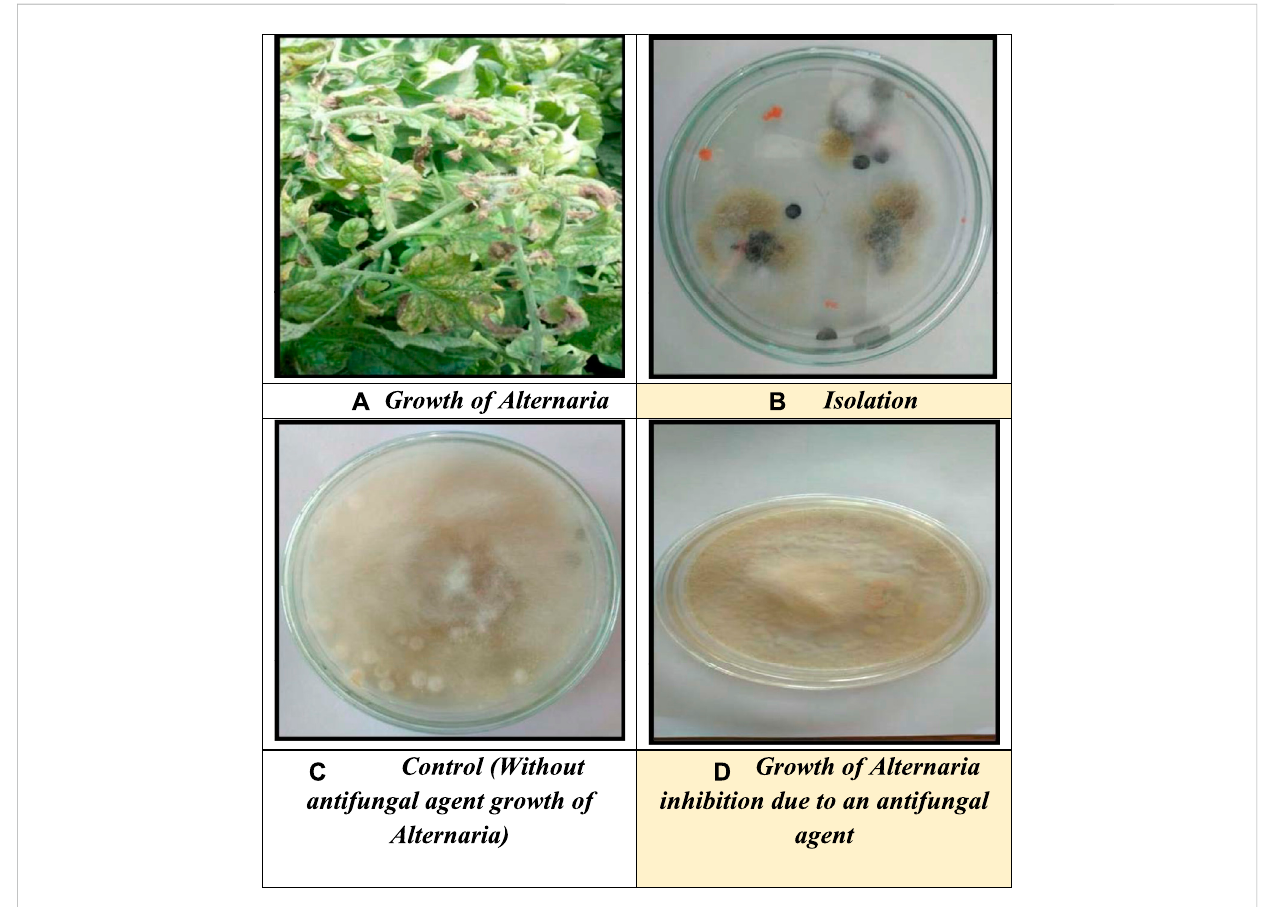
FIGURE 8 (A) GrowthofAlternaria, (B) isolation, (C) control(withoutantifungalagentgrowthofAlternaria),and (D)